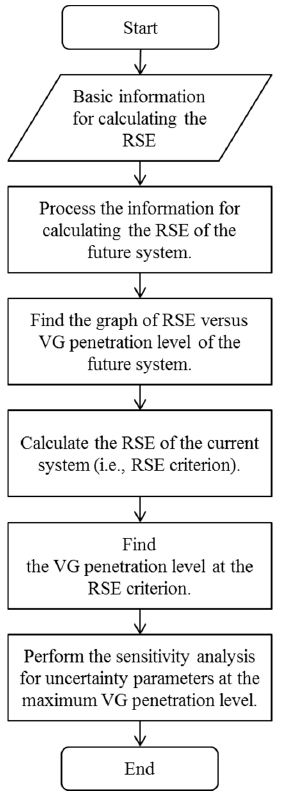
Figure 1. Flexibility-based evaluation process of variable generation (VG) acceptability.